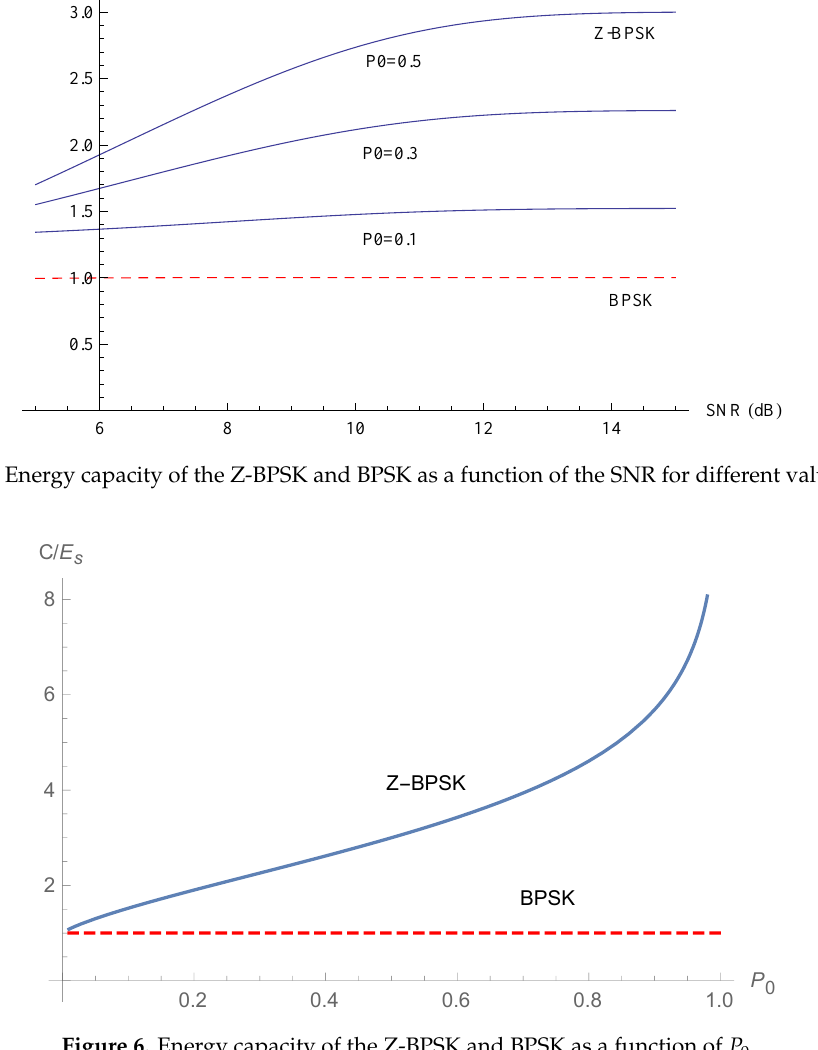
Figure 6. Energy capacity of the Z-BPSK and BPSK as a function of P 0